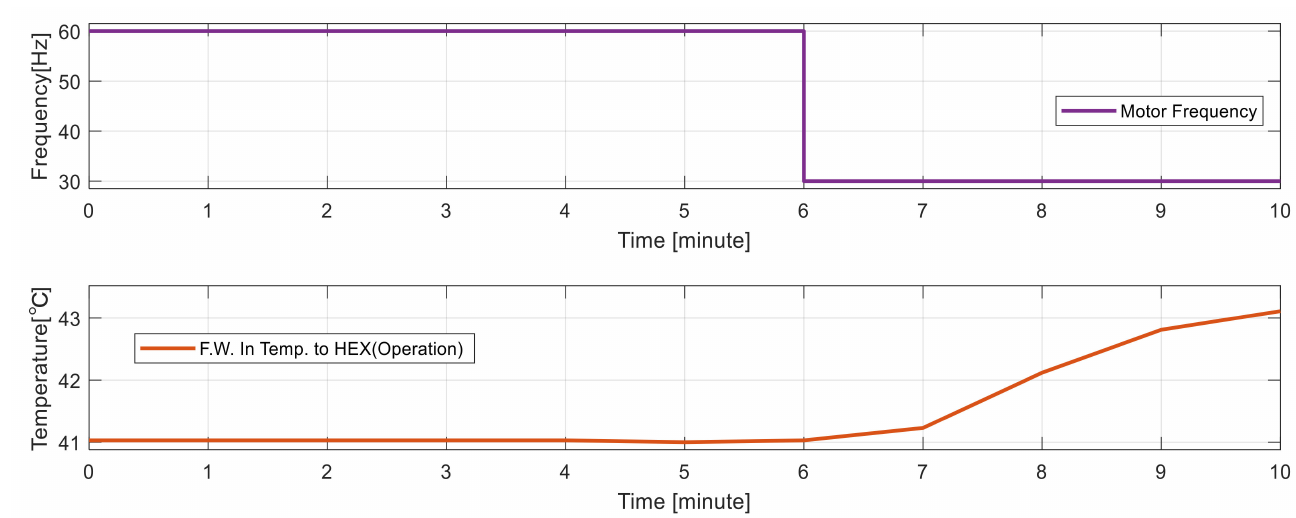
Figure 14. Step down input to SW pump and FW inlet temperature to heat exchanger.